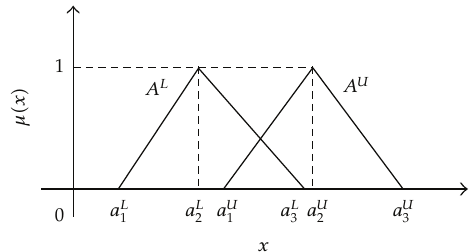
Figure 2: An interval-typed triangular fuzzy number (cid:6) A L , A U (cid:7)